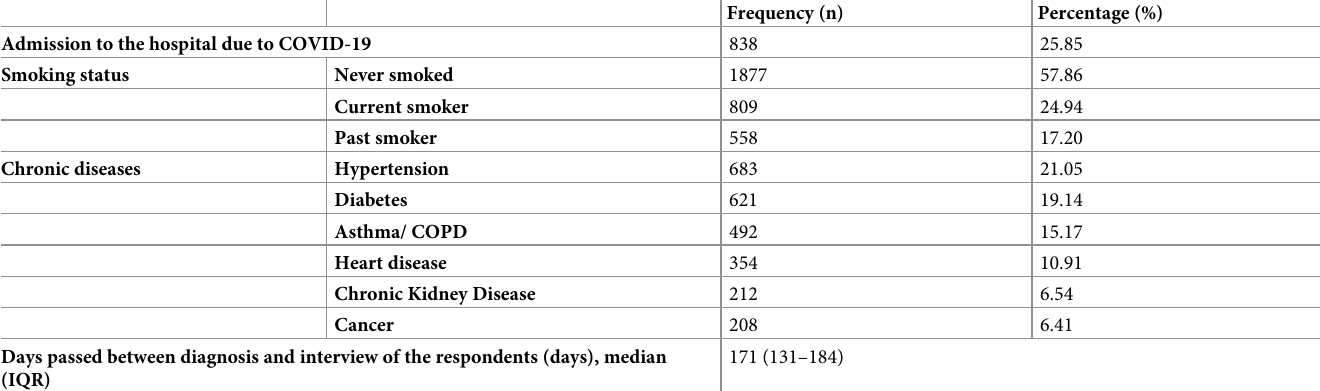
Table 2. History of hospital admission, smoking status, comorbidity profile and days passed between diagnosis and interview of the respondents.